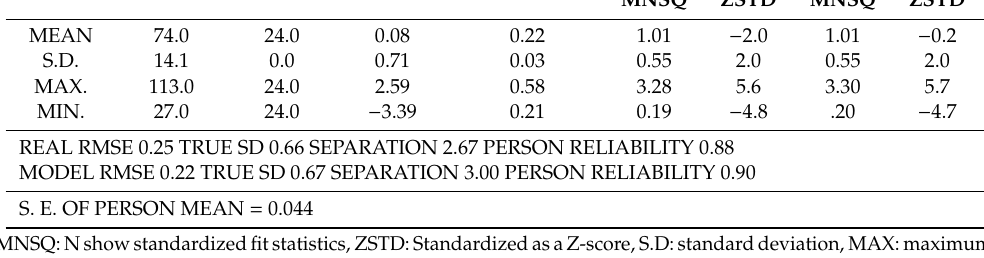
Table 4. Subject reliability of taekwondo electronic protector cognition scale. TOTAL COUNT MEASURE SCORE